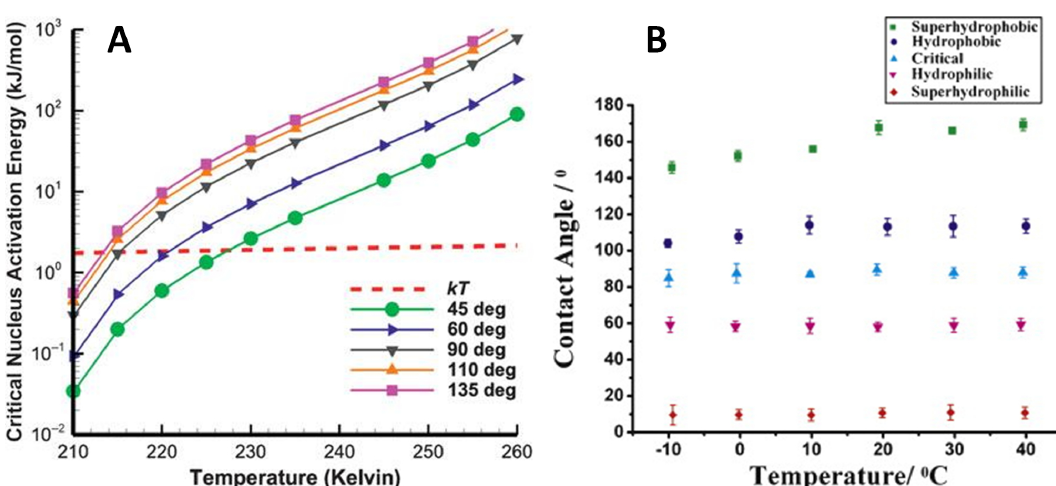
Figure 3. ( A ) Shows variation of activation energy for critical nucleation with temperature for different wettabilities. Red line represents region below which spontaneous freezing occurs; ( B ) Shows variation of contact angle with temeprature for surface with differing wettabilities. Reprinted with permission from Refs. [22,61], respectively. c (cid:13) 2013 Materials Research Society; c (cid:13) 2010